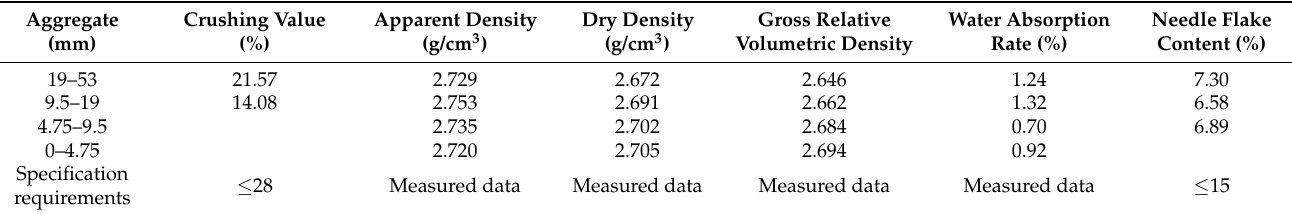
Table 1. Technical specifications of